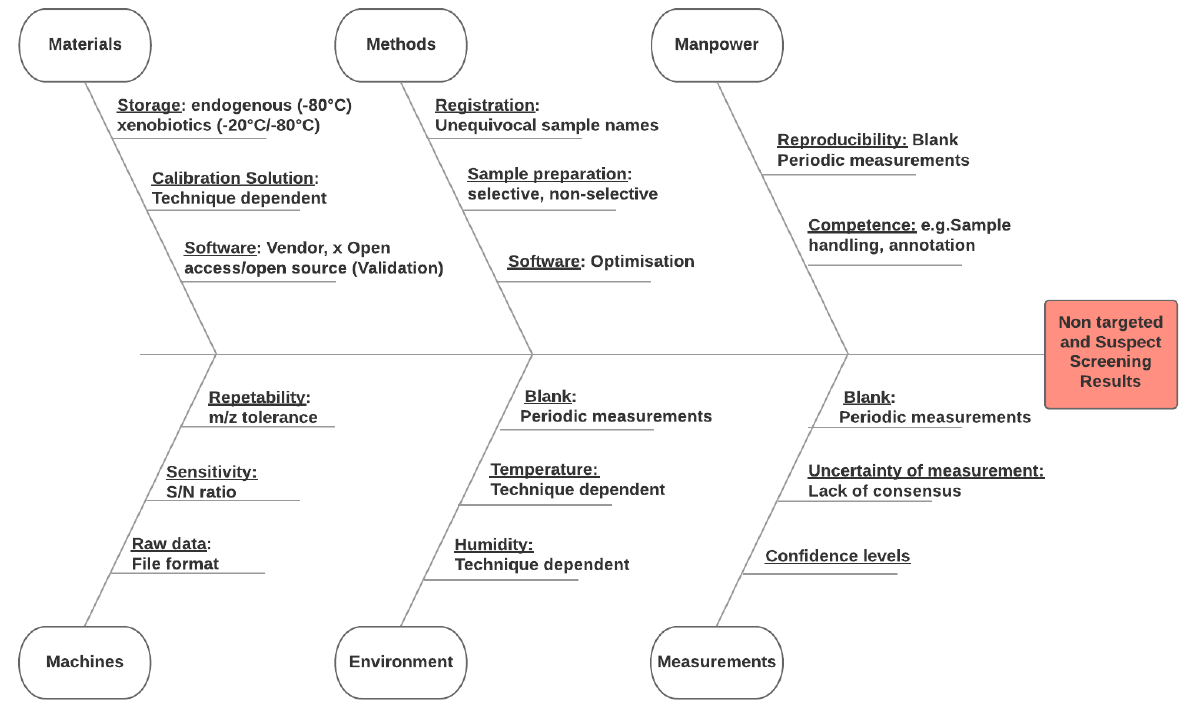
Figure 2. Non-exhaustive Ishikawa diagram for non-targeted and suspect screening methodologies. Materials can refer to samples, reference or standard solutions, or software tools used for acquisition and/or data treatment. Storage of samples is a critical point as temperature must be controlled to avoid analyte loss or degradation. Since compound-specific freezing study would be a limited option for a NTA study, all precautions must be taken to protect the sample from degradation as a whole. A storing temperature of − 80 ◦ C is usually preferred and recommended, particularly for biological matrices. Calibration solutions are also a point to consider carefully, as NTA/SS methods using HRMS rely on accurate mass. Frequency of calibration can vary based on the used instrument: time-of-flight (TOF) instruments usually offer real-time calibration (up to a calibration for each sample), whereas Orbitrap instruments may be calibrated weekly. Another example worth discussion is the Laboratory information management system (LIMS), which has to be dimensioned